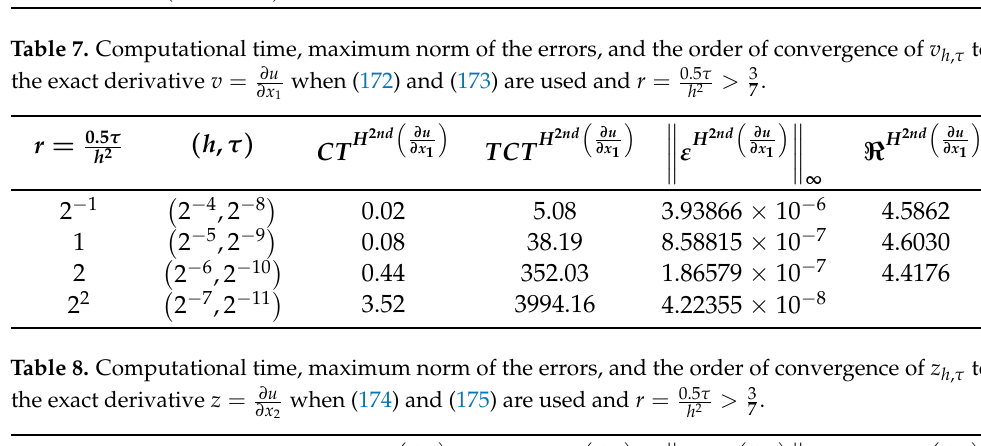
Table 8. Computational time, maximum norm of the errors, and the order of convergence of z h , τ to the exact derivative z = ∂ u when (174) and (175) are used and r = 0.5 τ ∂ x 2 r = 0.5 τ h